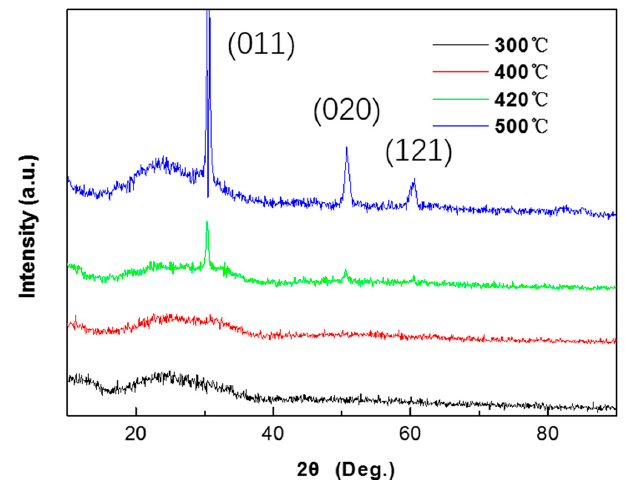
Figure 3. X-ray diffraction (XRD) scans obtained from ZrO 2 film coated on the glass of a different annealing temperature.